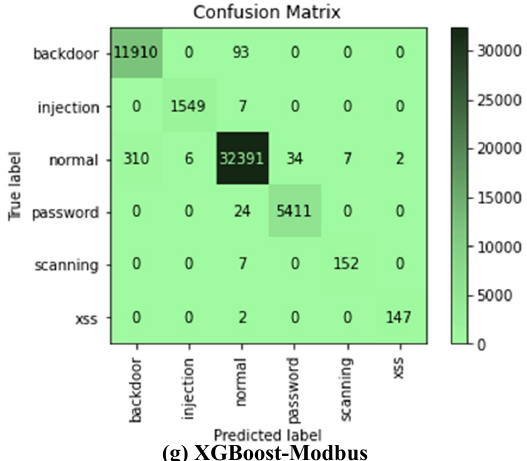
Figure 2. ( a – g ) XGBoost confusion matrix for all datasets considered in this study.